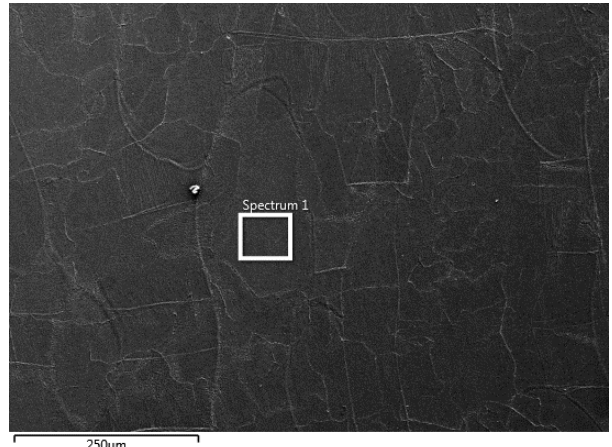
Figure 8. Representative SEM image of cross section oriented in the xy -plane used for EDS analysis. EDS spectrum collected from area marked “Spectrum 1” contained within a single microstructural